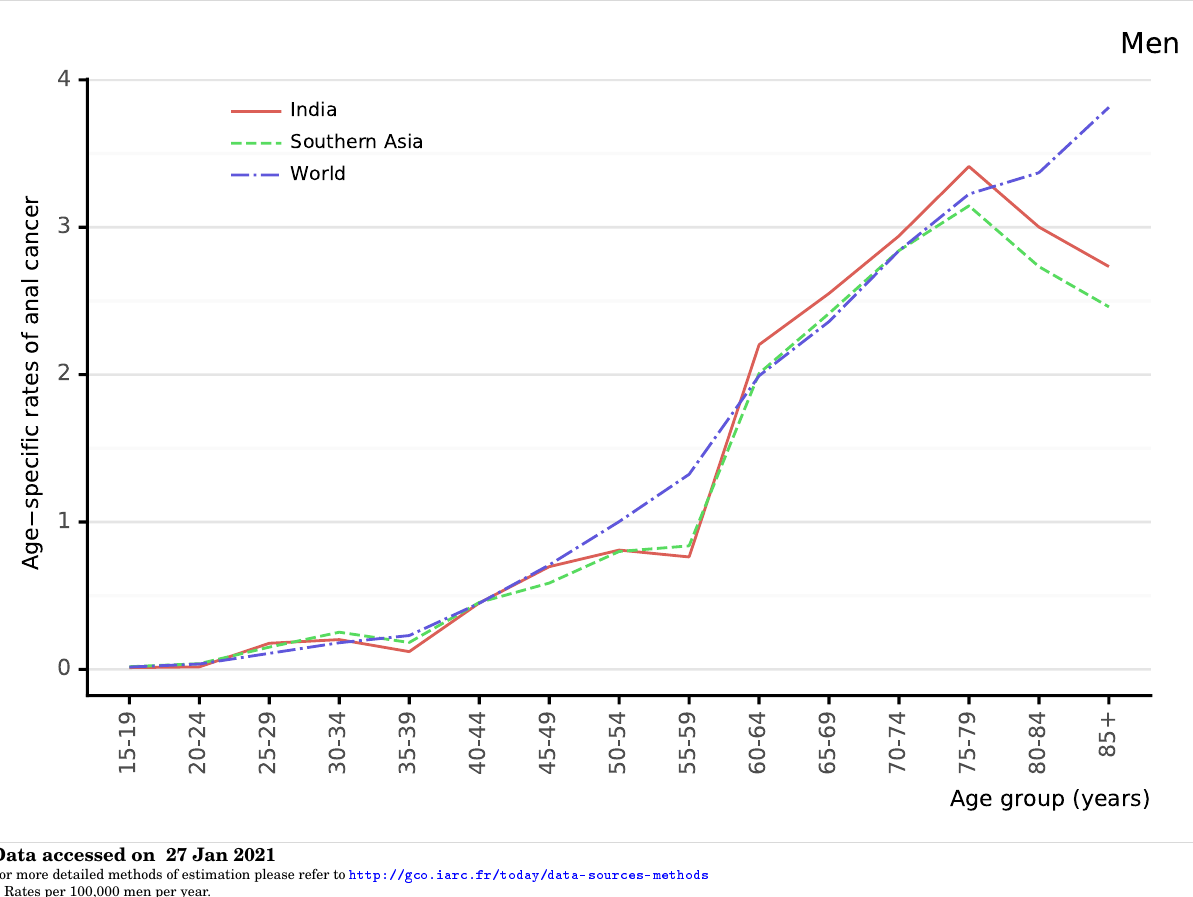
Figure 79: Comparison of age-specific anal cancer incidence rates among men by age in India, within the region, and the rest of